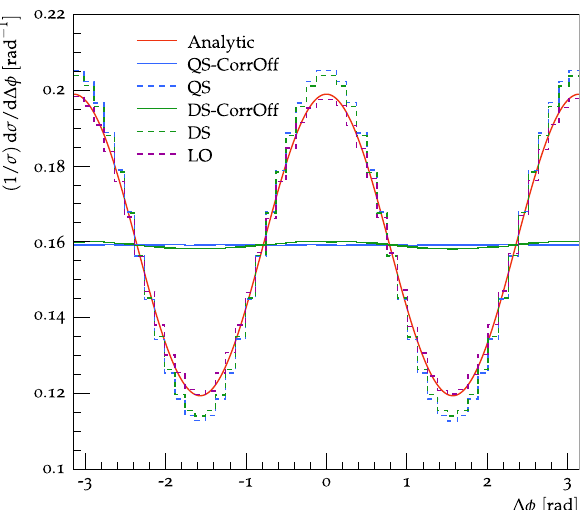
Fig. 4 The difference in azimuthal angle between the planes of two initial-state g → q ¯ q branchings in gg → h 0 predicted using the angular-ordered (QS) parton shower in Herwig 7. The angular-ordered parton shower (QS-CorrOff) prediction without spin correlations is also included. The result obtained from a sample of LO events generated using MadGraph5_aMC@NLO (LO) is shown for